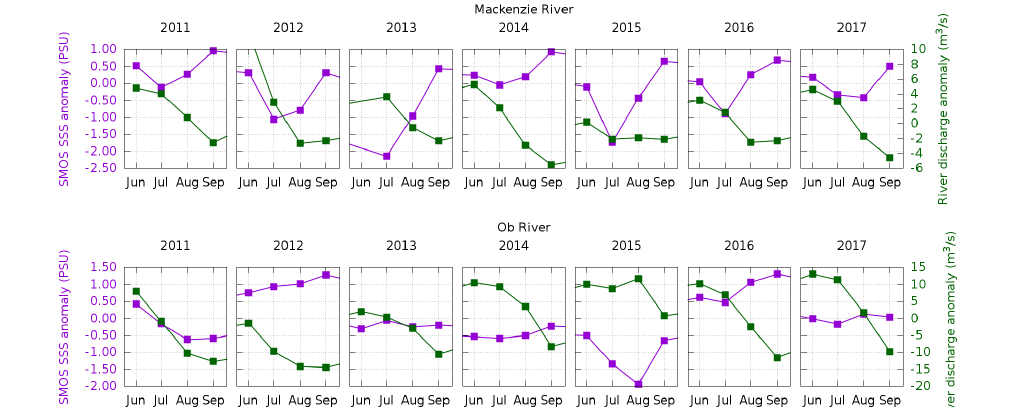
Figure 15. Monthly SMOS SSS anomaly (purple) versus monthly river discharge anomaly (green) from 2011 to 2017 from Arctic Great Rivers project: Mackenzie River ( top ); and Ob River ( bottom